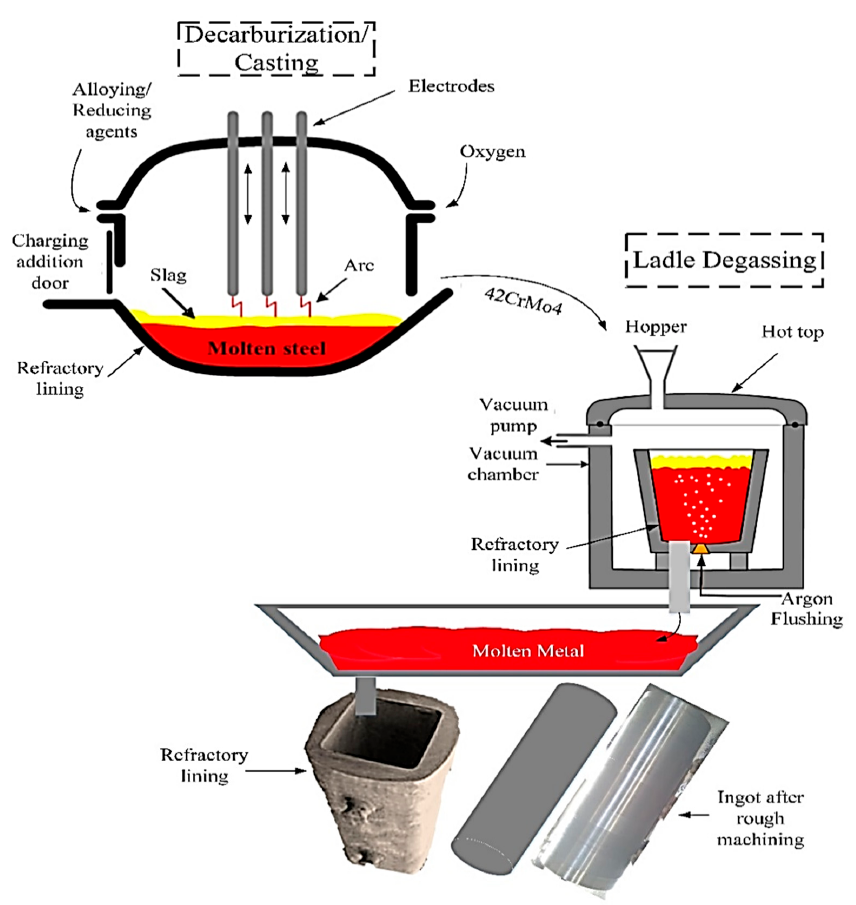
Figure 2. Possible sources contributing to the rejection of the roller shaft.